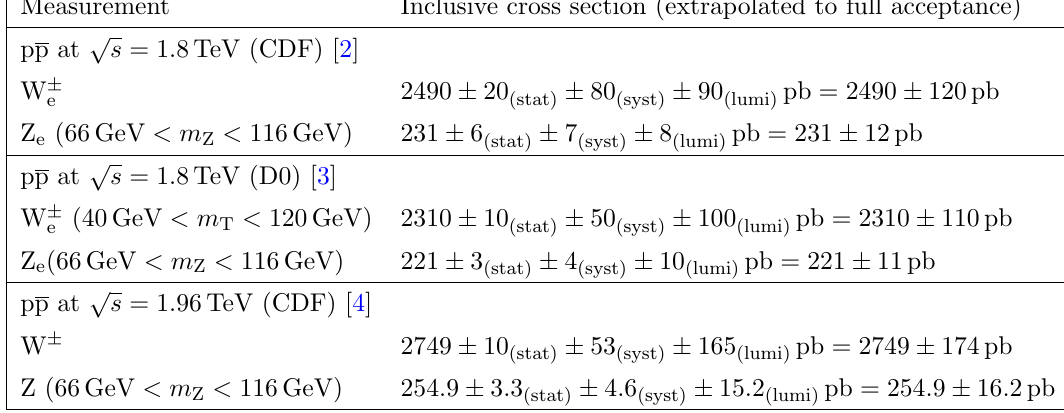
Table 3 . Compilation of the six CDF and D0 measurements of inclusive W (cid:6) and Z boson pro- p duction cross sections in pp collisions at s = 1 : 8 and 1.96 TeV [2{4], in the various leptonic (cid:12)nal states. The three sources of experimental uncertainties, and the selection criteria on the (W) Z (transverse) masses, are